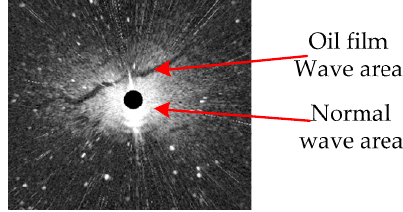
Figure 2. Comparison between normal and oil film wave regions.